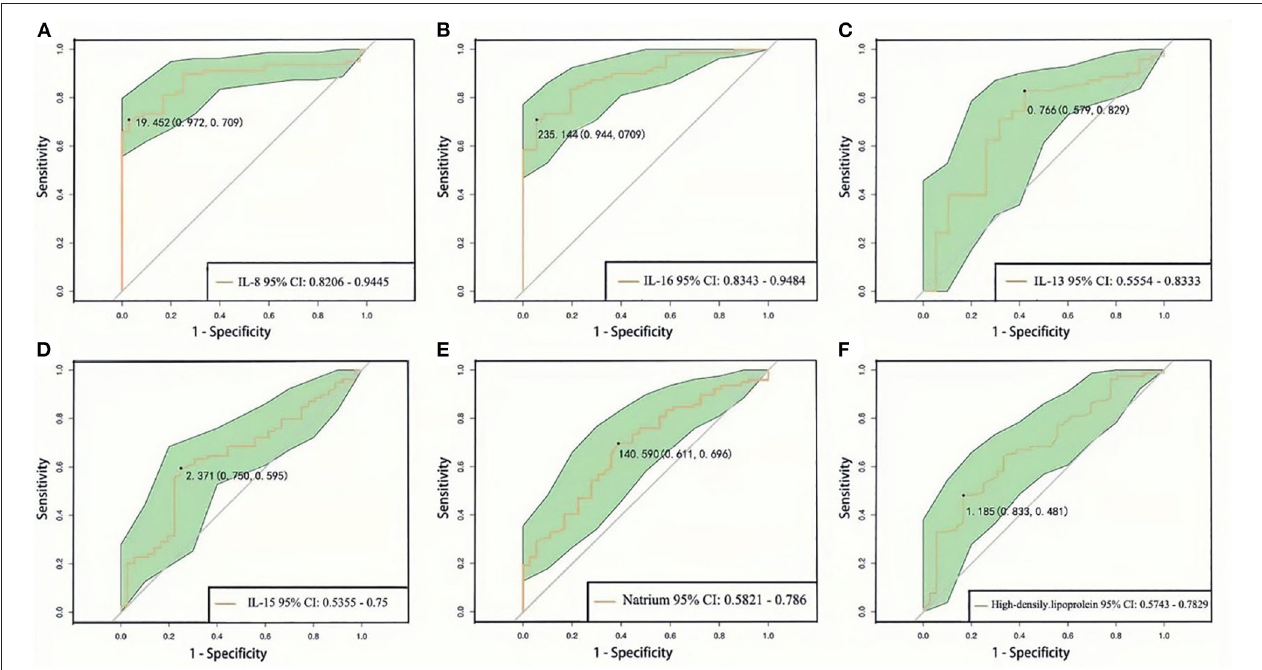
FIGURE 4 | ROC curve analysis of blood routine, biochemical, and inflammation cytokines between first episode drug-naïve schizophrenia patients and healthy controls (A–F) . 95% CI, 95% confidence interval.